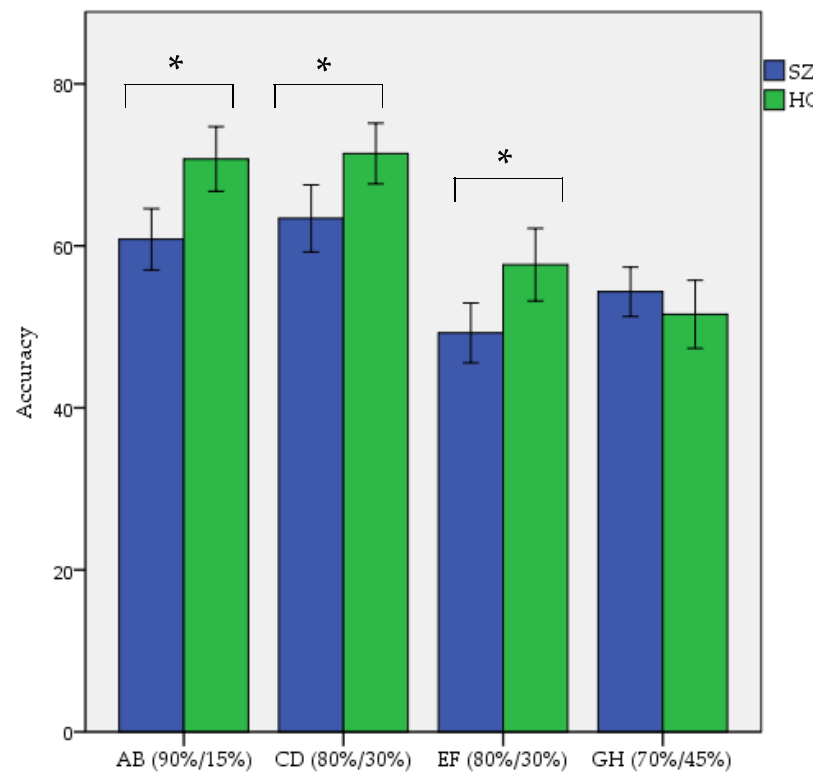
Figure 2. Comparison of acquisition of probabilistic contingencies during IPST for AB (90%/15%), CD (80%/30%), EF (80%/30%), and GH (70%/45%) conditions between schizophrenia (SZ) patients and healthy control (HC) participants. Green color refers to HC participants and blue color refers to the patients with SZ, * refers to statistically significant differences.